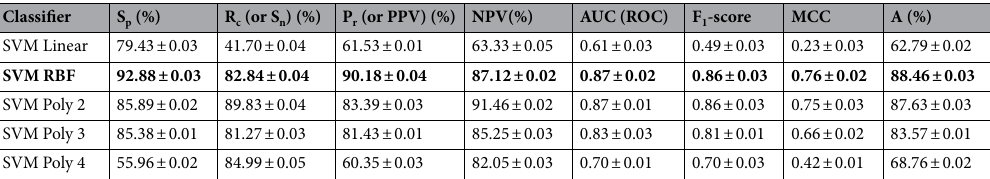
Table 8. Proposed system results (tenfold-cross validated) with five epochs depicting analysis based on performance using SVM for BraTS-2021 dataset (with RA). Significant values are given in bold.